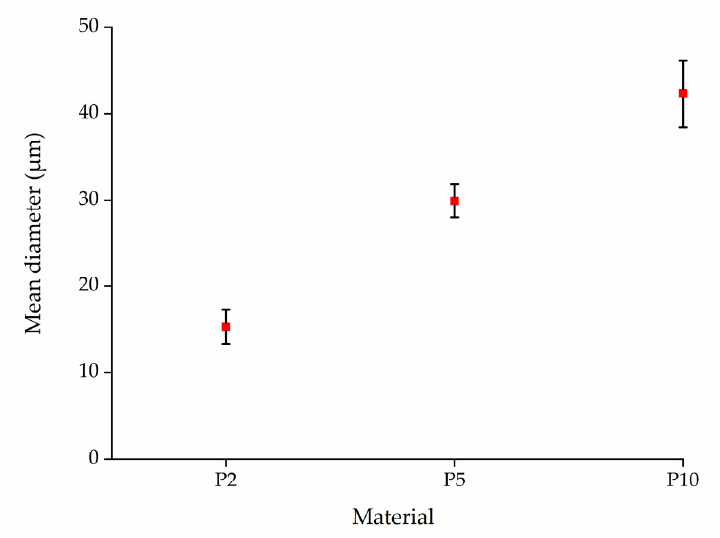
Figure 17. Mean diameter of fibers in webs prepared from pure PLA at different pump speeds of 2 rpm (P2), 5 rpm (P5), and 10 rpm (P10).